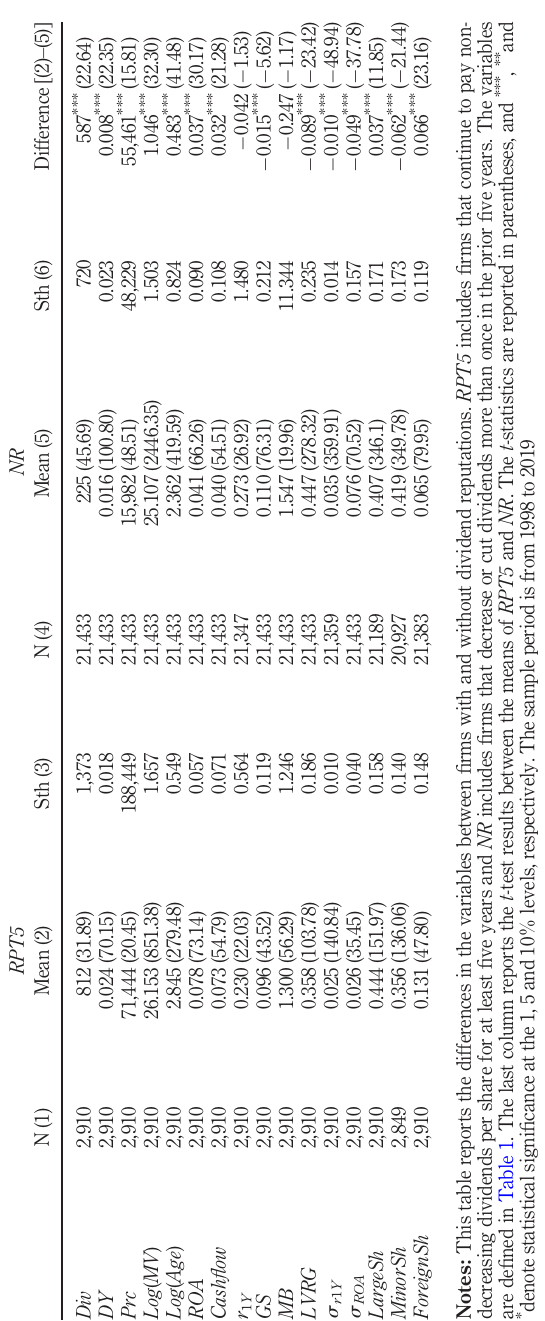
Table 3. Differences between firms with and without dividend